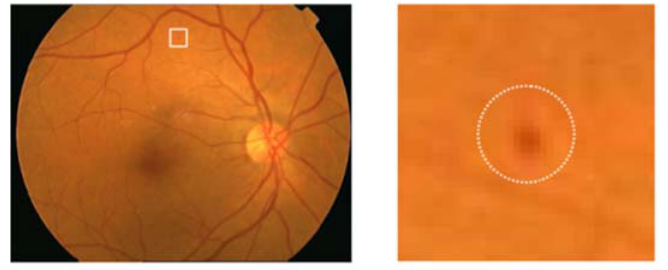
Figure 3. Encircled mark of the microaneurysms taken from the original fundus image.